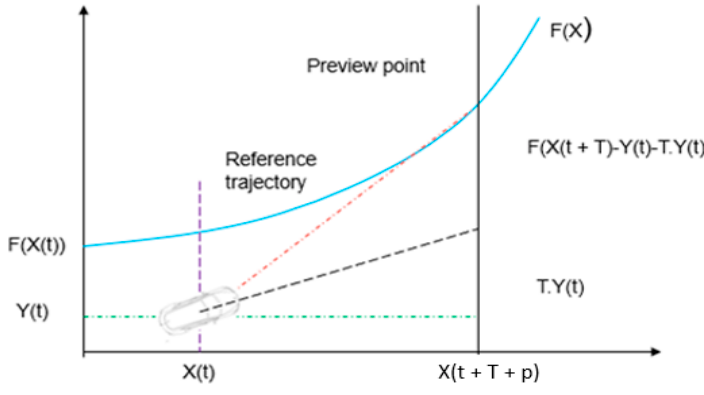
Figure 4. Preview capability of MPC.